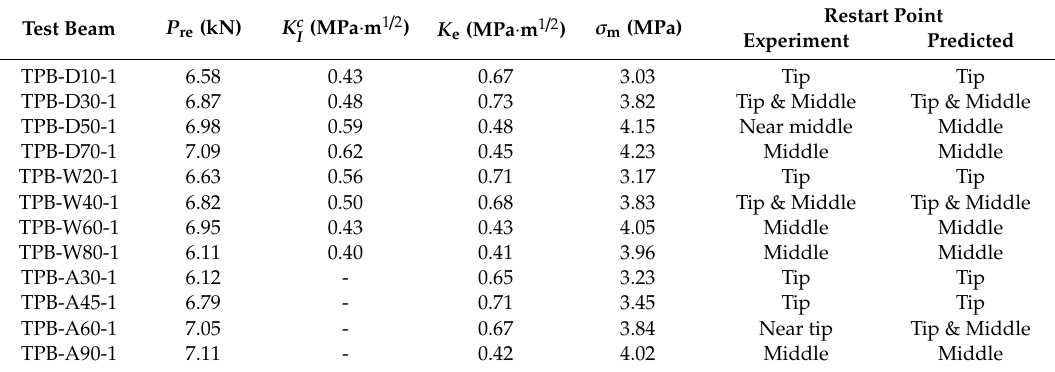
Table 5. The predicted results and the experimental results of the crack restart